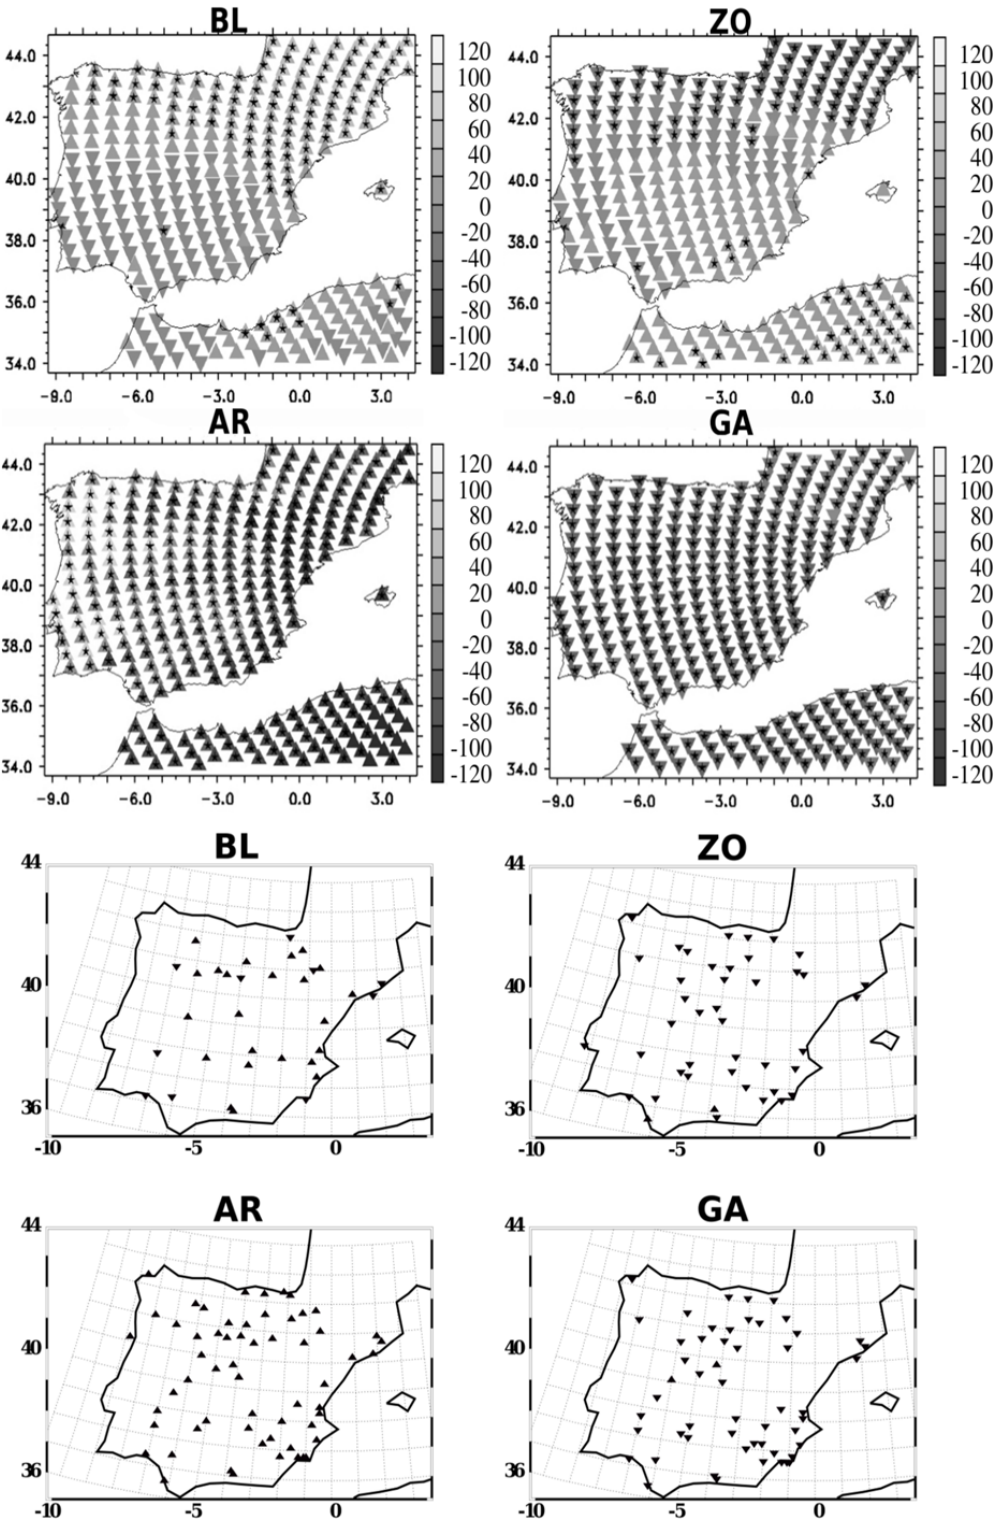
Fig. 3. Dependence of extreme values of minimum temperature on LAR. First and second row, the dependence in the historical simulations: first row, BL (left), ZO (right), second row, AR (left), GA (right). Symbols as previously. Third and fourth row, the dependence in the observations: third row, BL (left), ZO (right), fourth row, AR (left), GA (right). Up-tipped triangles denote increases (with respect to the pooled decile values), down-tipped triangles,